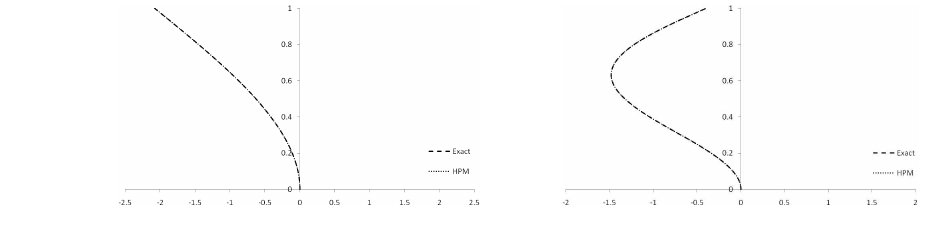
Figure 5. Mode shapes for the first mode – constant stiffness.